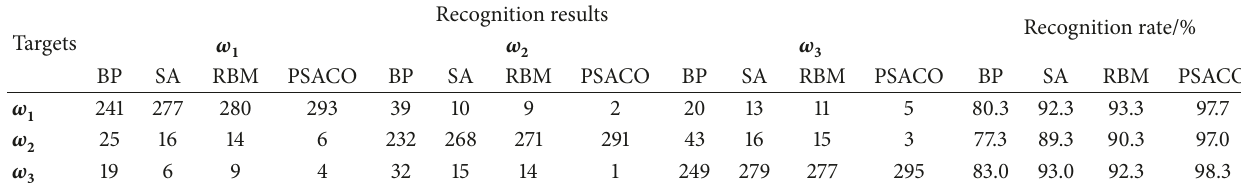
Table 11: Recognition results of CNIS-II for transformed